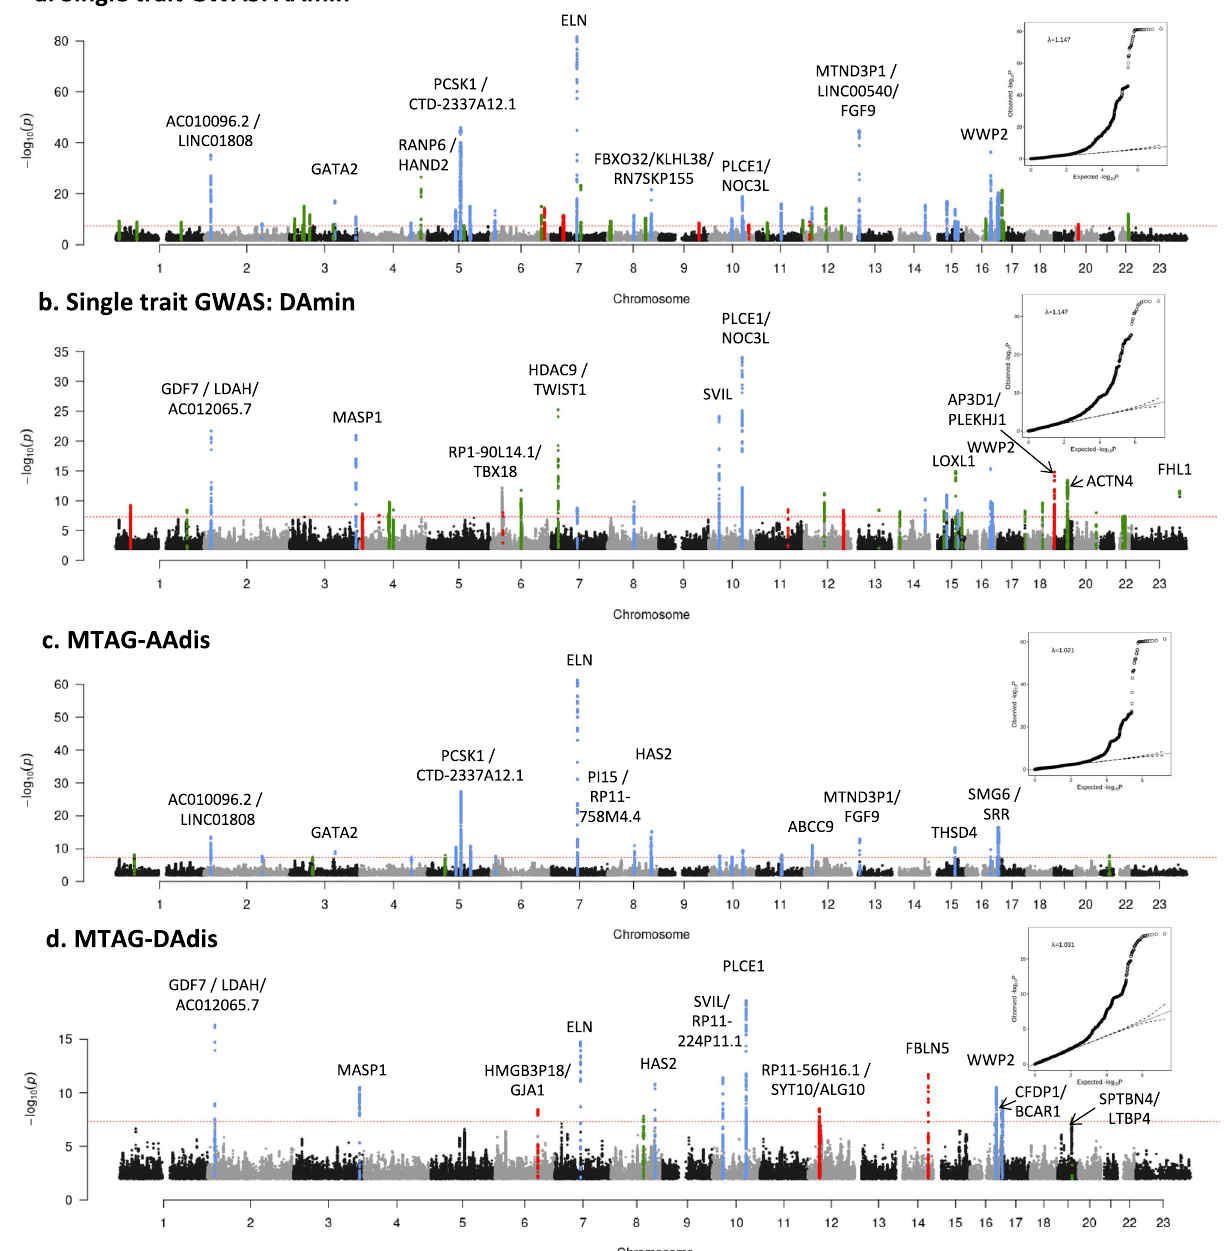
Fig. 1 | Manhattan plots of summary statistics from GWAS of aortic traits. a Single-traitanalysisofascending aortic minimum area (AAmin) and b single-trait analysis of descending aortic minimum area (DAmin). Genomic in fl ation ( λ )=1.147 (Aamin and Damin).The y axis shows the negative log of the unadjusted p value of association (mixed model association implemented in BOLT-LMM 89 ). c Multi-trait analysis(MTAG)ofascending aorticdistensibility (AAdis)and d Multi-trait analysis ofdescendingaorticdistensibility(DAdis).Theyaxisshowstheunadjusted p value of association (using MTAG 28 asdiscussedinMethods);negative log scale.Twenty- six association signals were identi fi ed in multi-trait analysis of ascending aortic distensibility (AAdis) and thirteen in multi-trait analysis of descending